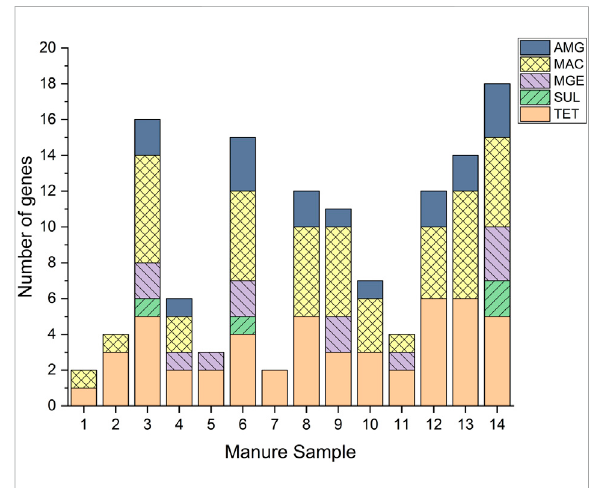
FIGURE 3 Antimicrobial resistance gene presence in 14 swine manure samples from Iowa farms, measured by quantitative polymerase chain reaction (qPCR). Quanti fi ed genes: Tetracycline gene ( tetM ), and macrolide gene ( ermB ). Gene classes: macrolide ( MAC ), aminoglycosides ( AMG ), sulfonamide ( SUL ), tetracycline ( TET ), and mobile genetic element ( MGE